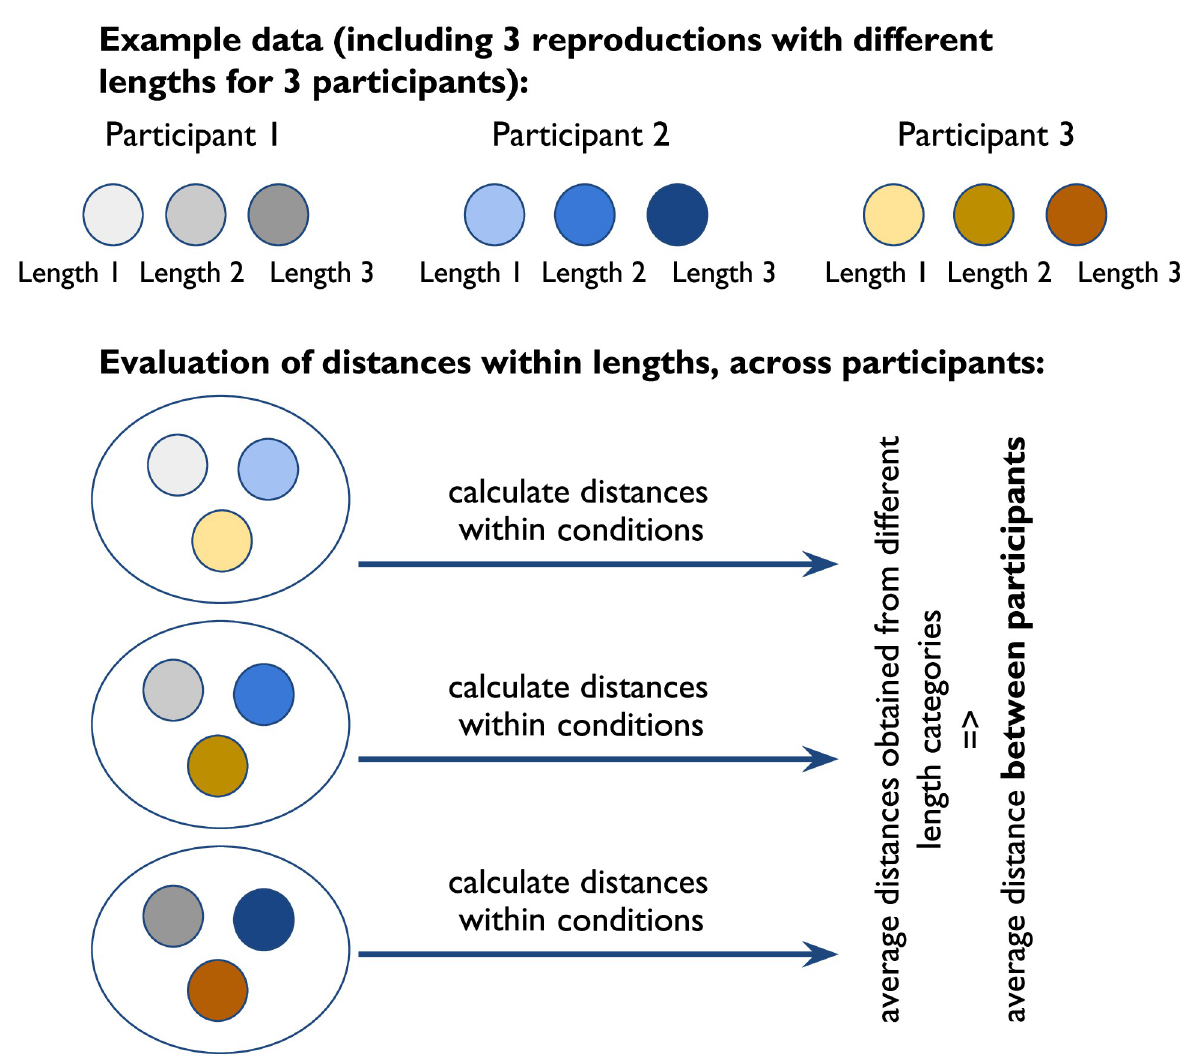
Fig 8. Explanation of how the pairwise distances across participants were computed from the neural activation traces. Each circle represents one trajectory of 25 × 22 where 25 is the number of neurons and 22 is the number of time steps. Data is split into 11 length categories and the pairwise distances within conditions are computed for each length category individually and later averaged, such that differences between lengths do not affect the final measure. The final measure, thus, shows for each time step the average distance between participants (cf. Fig 9).